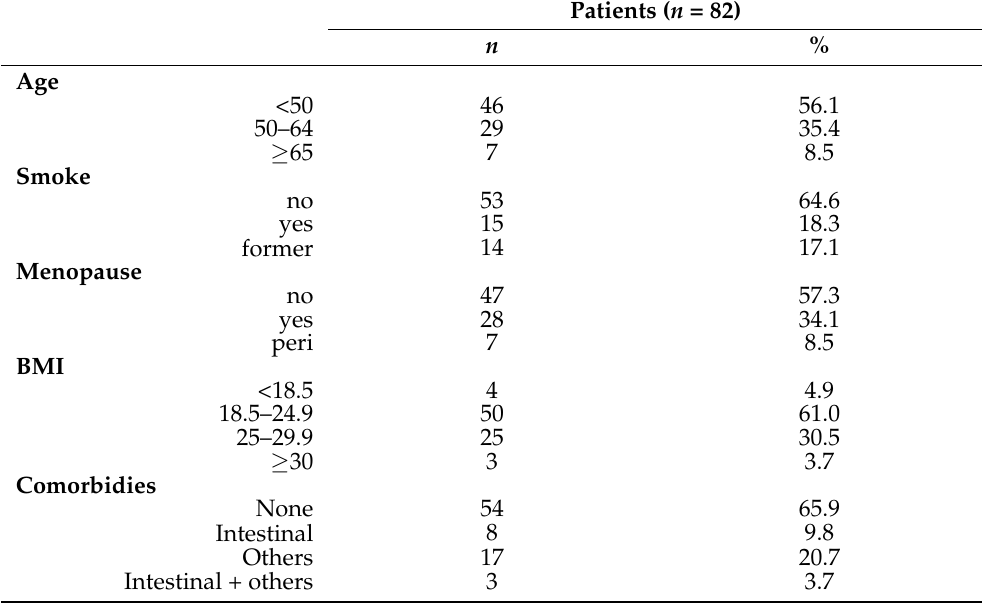
Table 1. Demographic and clinical BC patients’